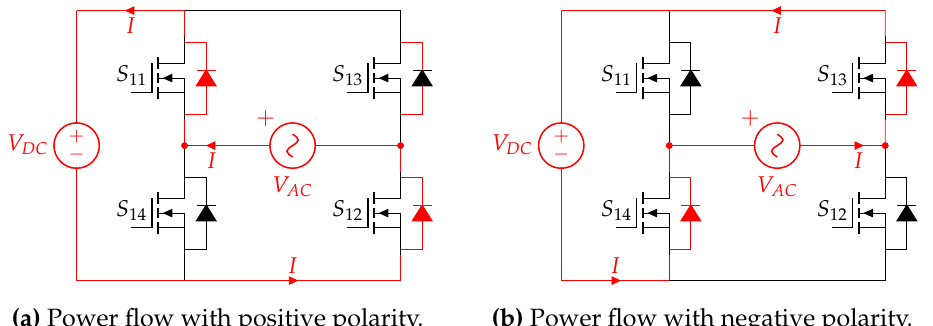
Figure 7. Output voltage in a full-bridge inverter with an square-wave activation and phase- shifting.